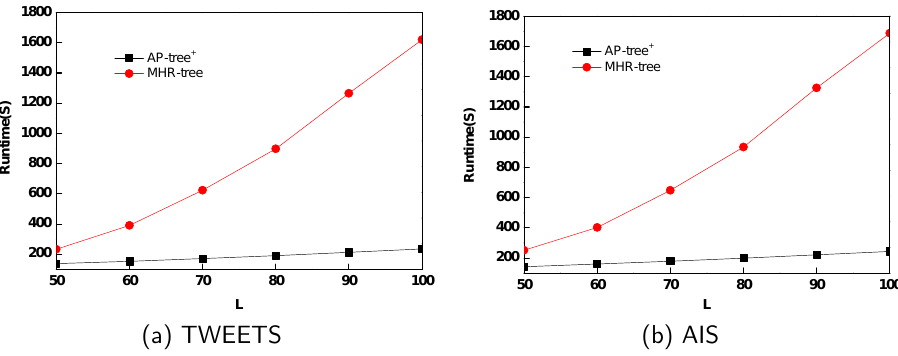
Figure 9. The maintenance cost of AP-tree + with various numbers of queries.